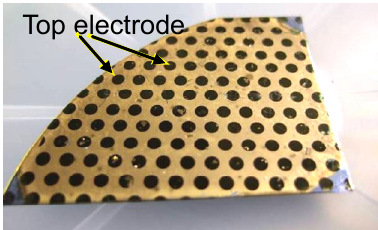
Figure 9. Photograph of fabricated tactile sensors using poly-urethane thin film and Au electrodes. Diameter of circular Au electrode (dark gold color) is 1 mm. Top